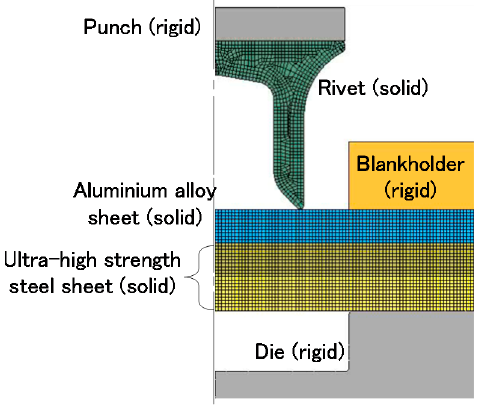
Figure 5. Conditions of simulation in self-pierce riveting for three sheets and for the upper aluminium alloy sheet.